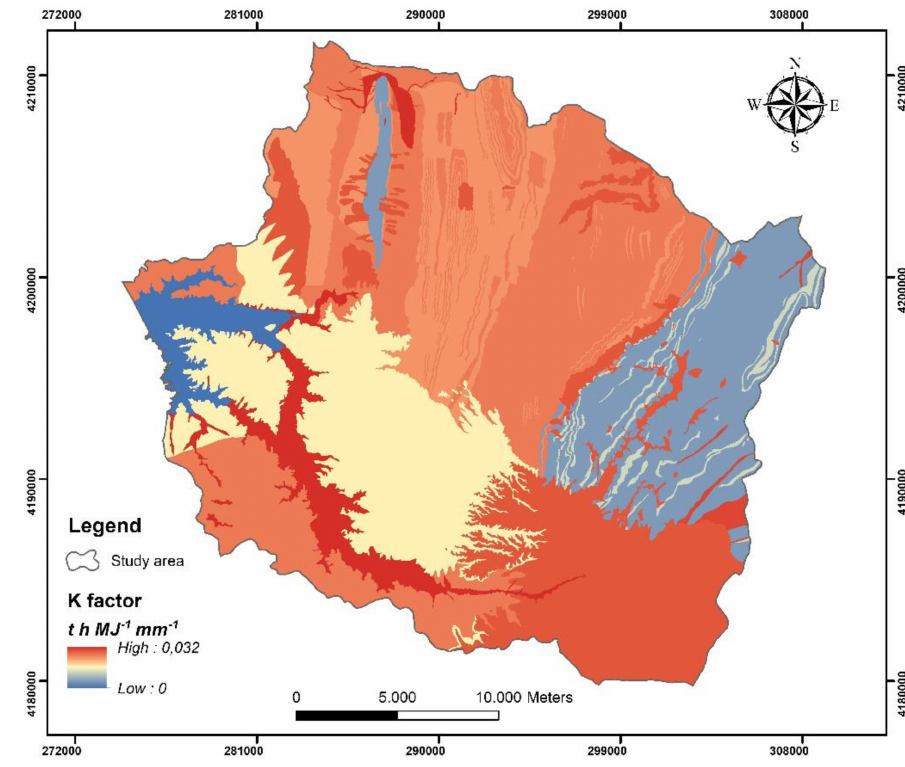
Figure 9. Soil erodibility factor (K) map of the pilot